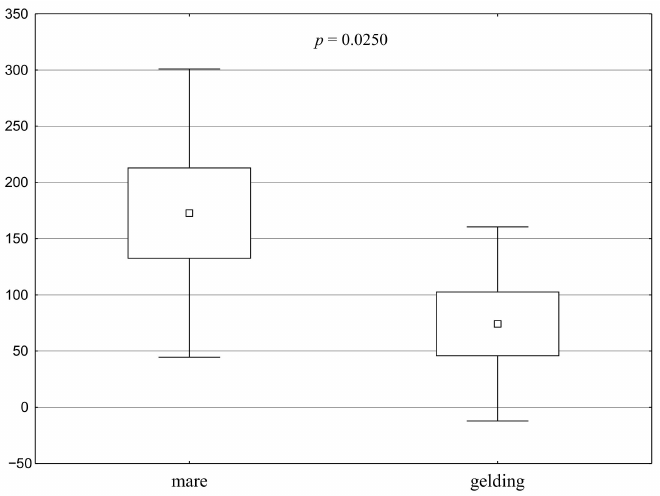
Figure 1. Distribution of Test 1 results for the groups—Passive human test: time after which the horse comes up to the person (s) (a square shows the mean, a box corresponds to the range of the mean ± standard error, and “whiskers” show the range of the mean ± standard deviation). A significant difference between the groups is confirmed by the value of p <